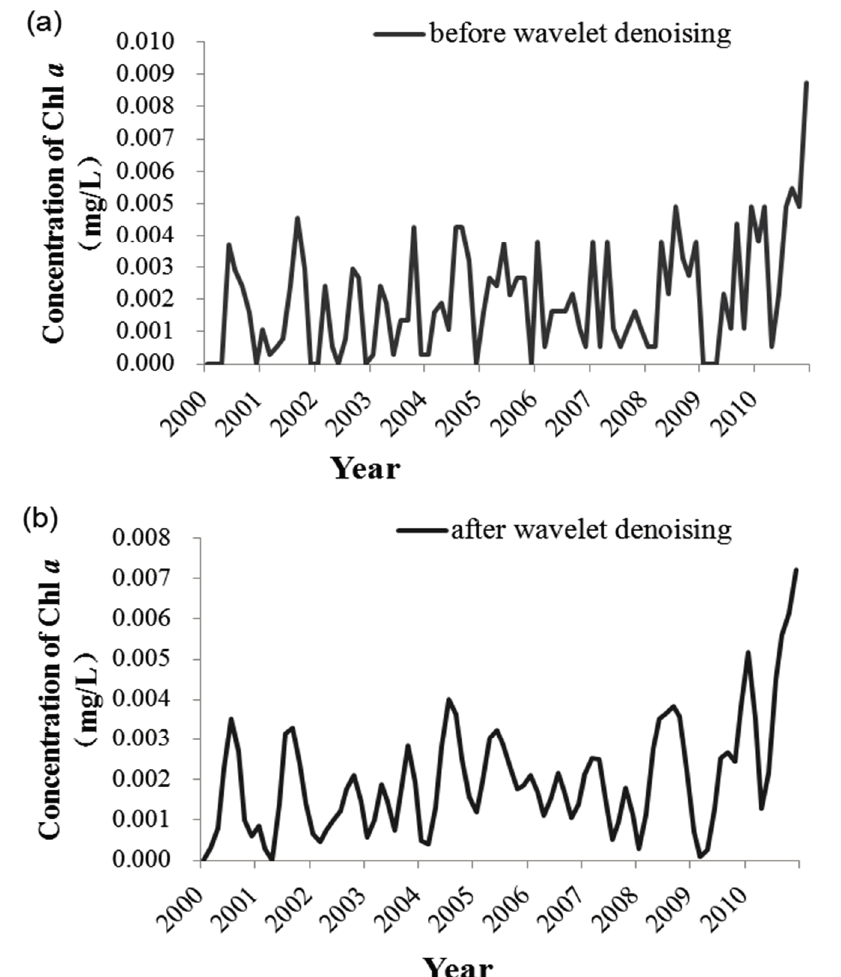
Figure 4. Comparisons of before and after the wavelet